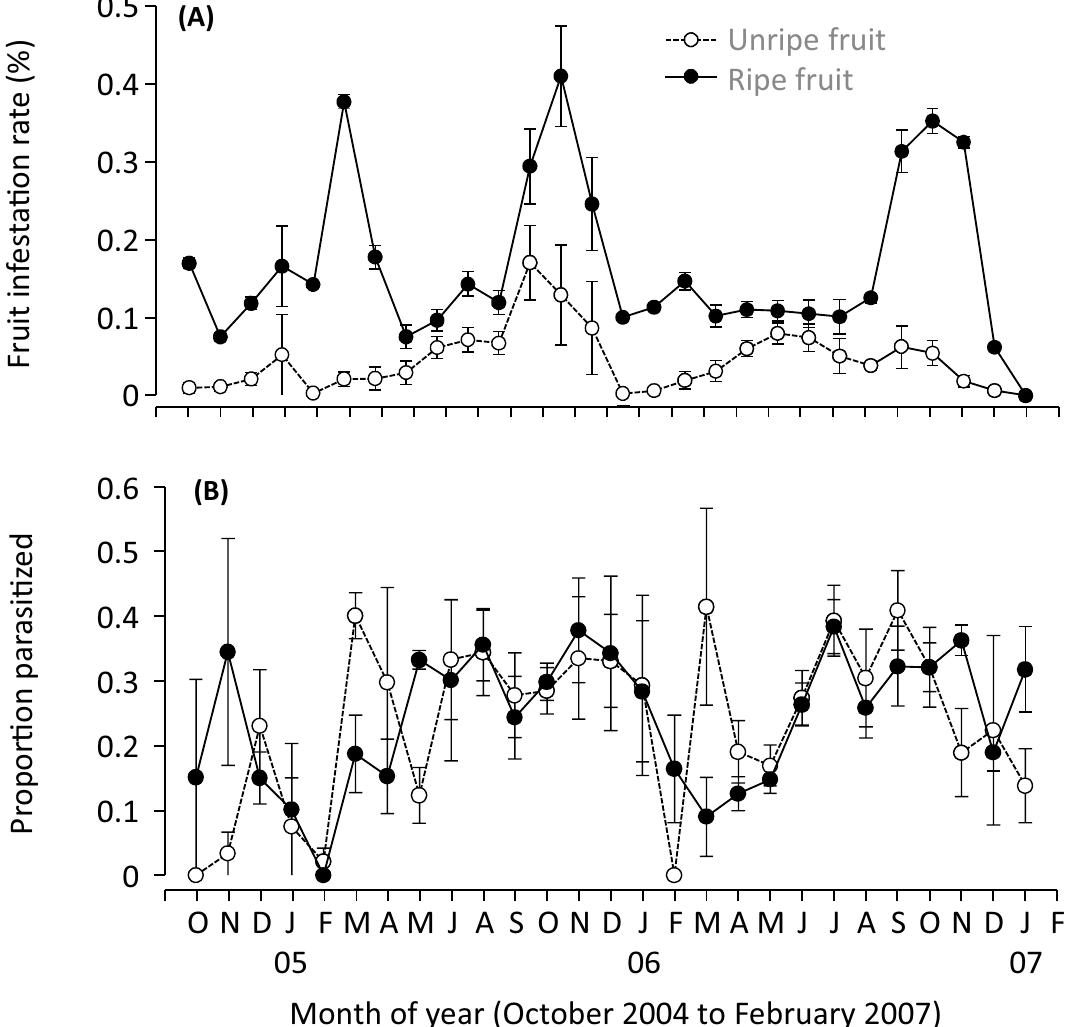
Figure 5. For both unripe and ripe fruit, the seasonal dynamics of ( A ) combined host density of B. oleae and B. biguttula and ( B ) apparent parasitism by braconid parasitoids from October 2004 to February 2007 in the Western Cape, South Africa. Values are mean and SE and data were pooled from different collection sites. The figure was created using JMP Pro ver13 (SAS, Cary, NC). Parameter Variables Estimate ± SE t